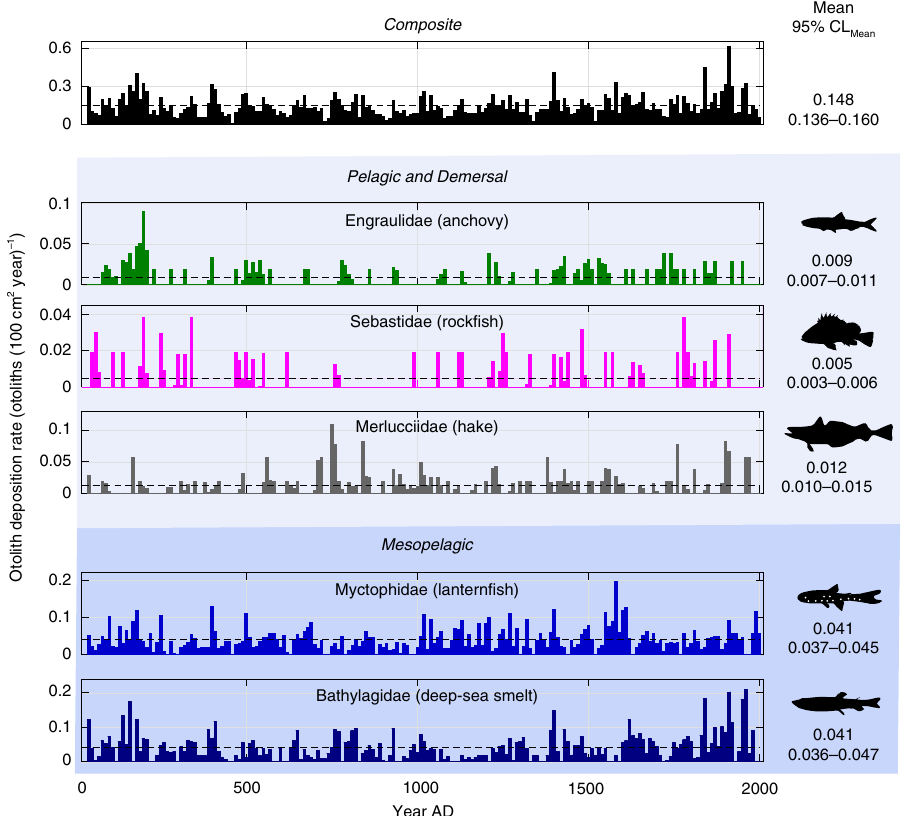
Fig. 2 Otolith deposition rates (ODR) for all fi shes and the fi ve dominant families. Vertical bars represent 10-year averages of ODR (otoliths (100cm 2 year) − 1 ). Mean ODR shown as horizontal dashed lines and on right with 95% con fi dence limit of mean ( n bins = 197). Composite includes otoliths from all fi ve families and unidenti fi ed (Other): n otoliths = 1188. Engraulidae: n otoliths = 77. Sebastidae: n otoliths = 46. Merlucciidae: n otoliths = 110. Myctophidae: n otoliths = 413. Bathylagidae: n otoliths = 367. Identi fi cation by expert opinion (see Methods section). Shading indicates upper ocean (light blue) and mesopelagic (dark blue). Source data are provided as a Source Data fi le